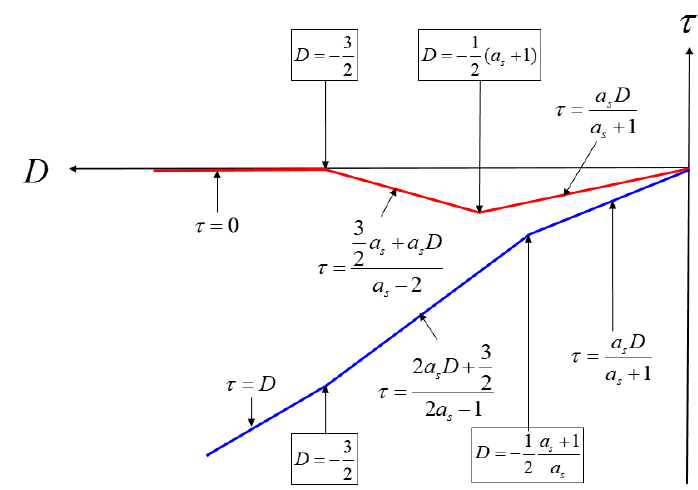
Figure 12. Summary of Equations (8) to (13).